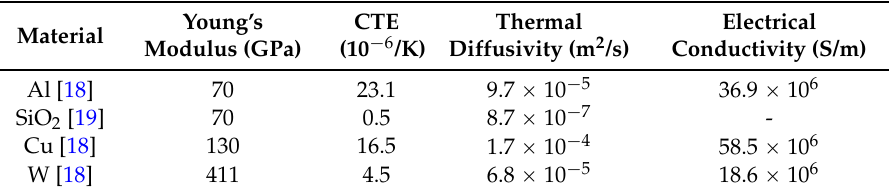
Table 1. Comparison of material properties of Al/SiO 2 and Cu/W bimorphs.